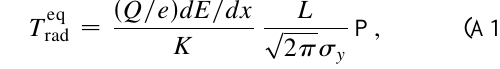
where the wire is assumed to be much smaller than the beam size, and the pulse repetition rate (P) is 120 Hz. The distance L to the heat sink is assumed to be 1 cm. The thermal conductivity of tungsten is K (cid:1) 146 W (cid:3) m ?